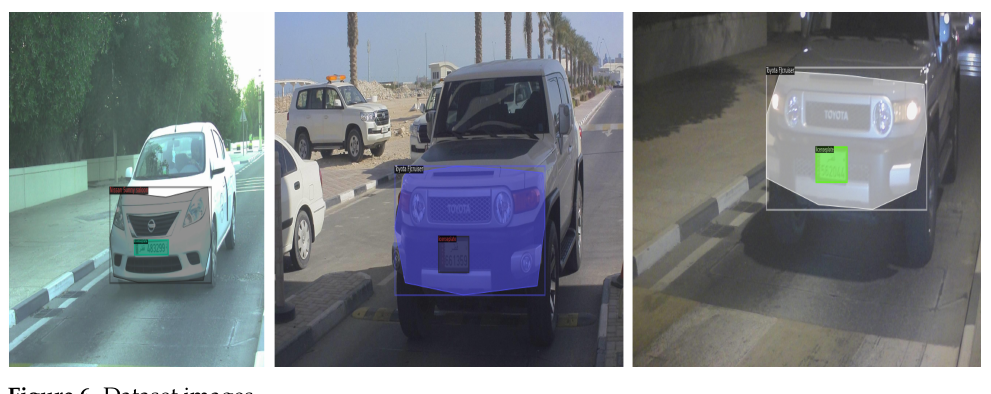
Figure 6. Dataset images.